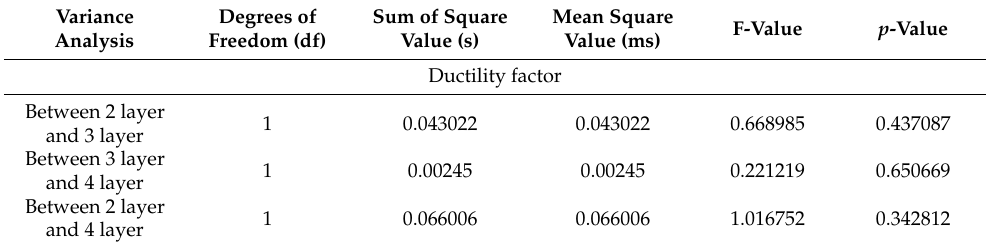
Table 8. Cont. Variance